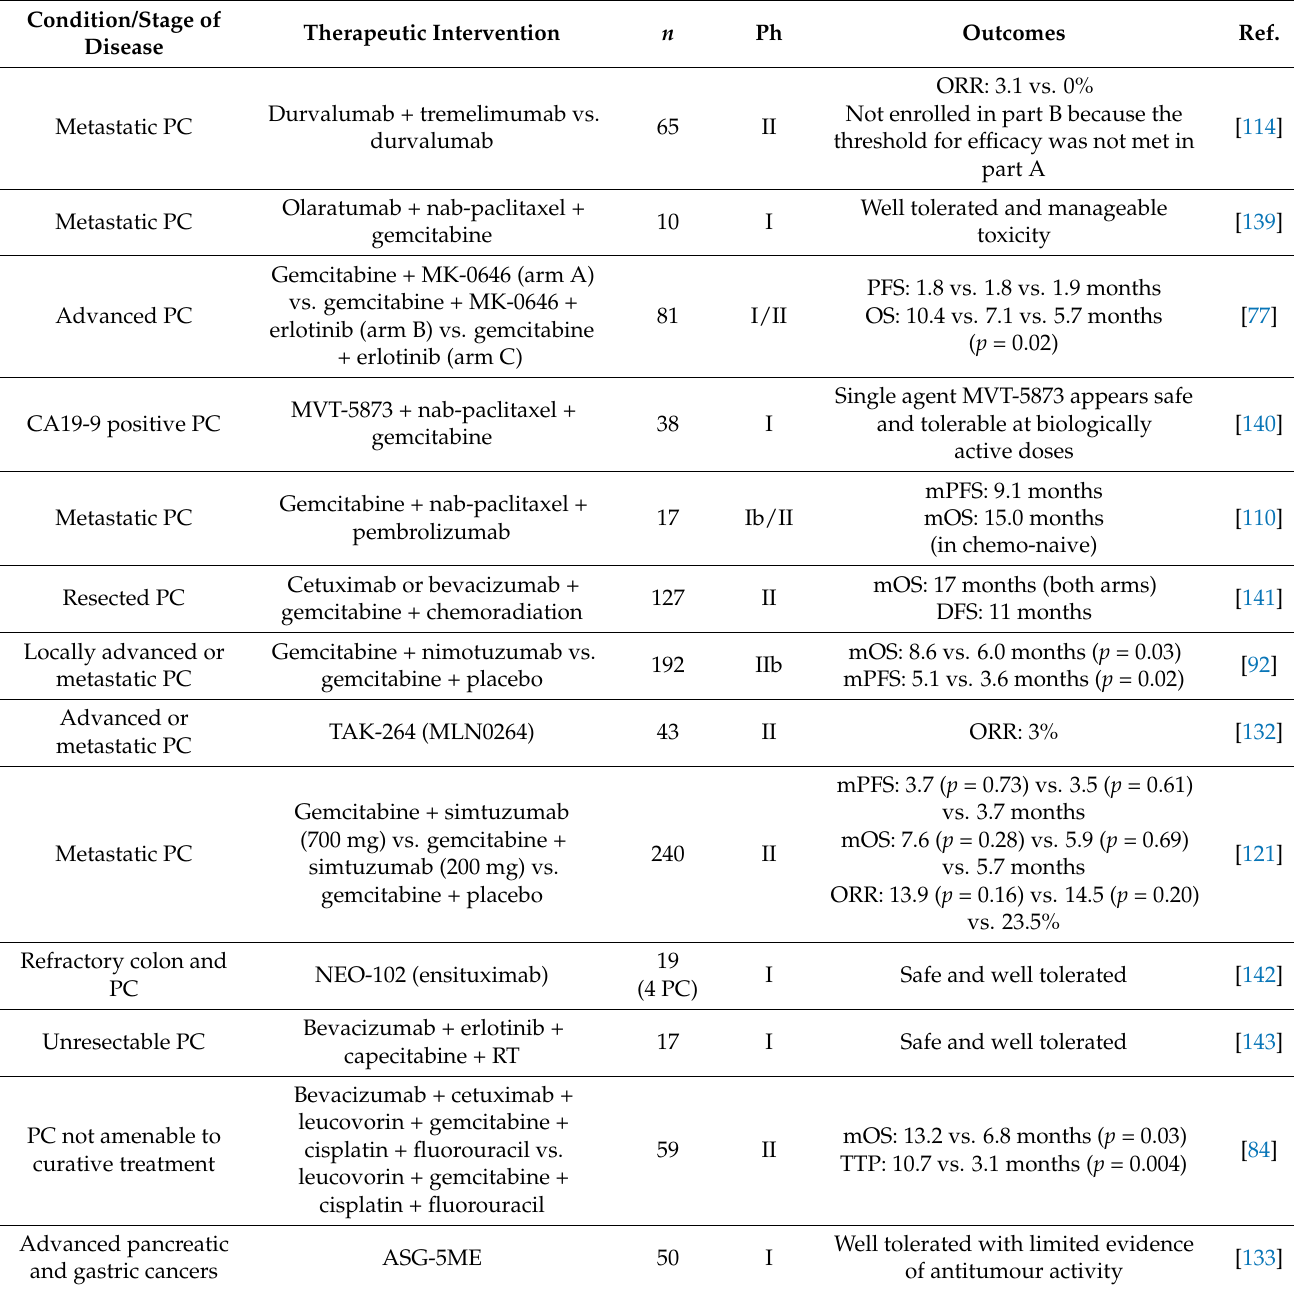
Table 4. Phase I/II clinical trials of monoclonal antibodies alone or in combination with other drugs in pancreatic cancer (www.clinicaltrials.gov accessed on 17 March 2021). Condition/Stage of